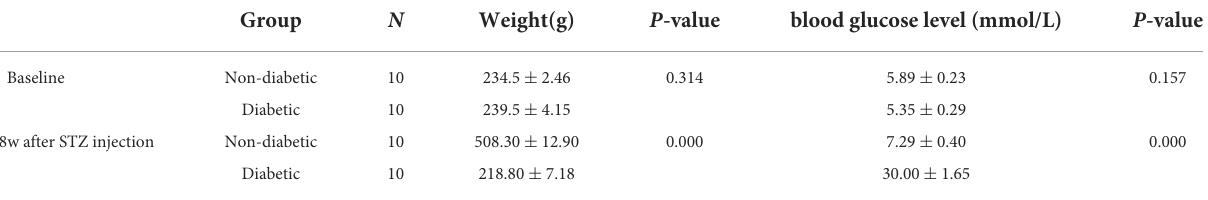
TABLE 1 Body weights and non-fasting blood glucose levels of non-diabetic and diabetic rats.